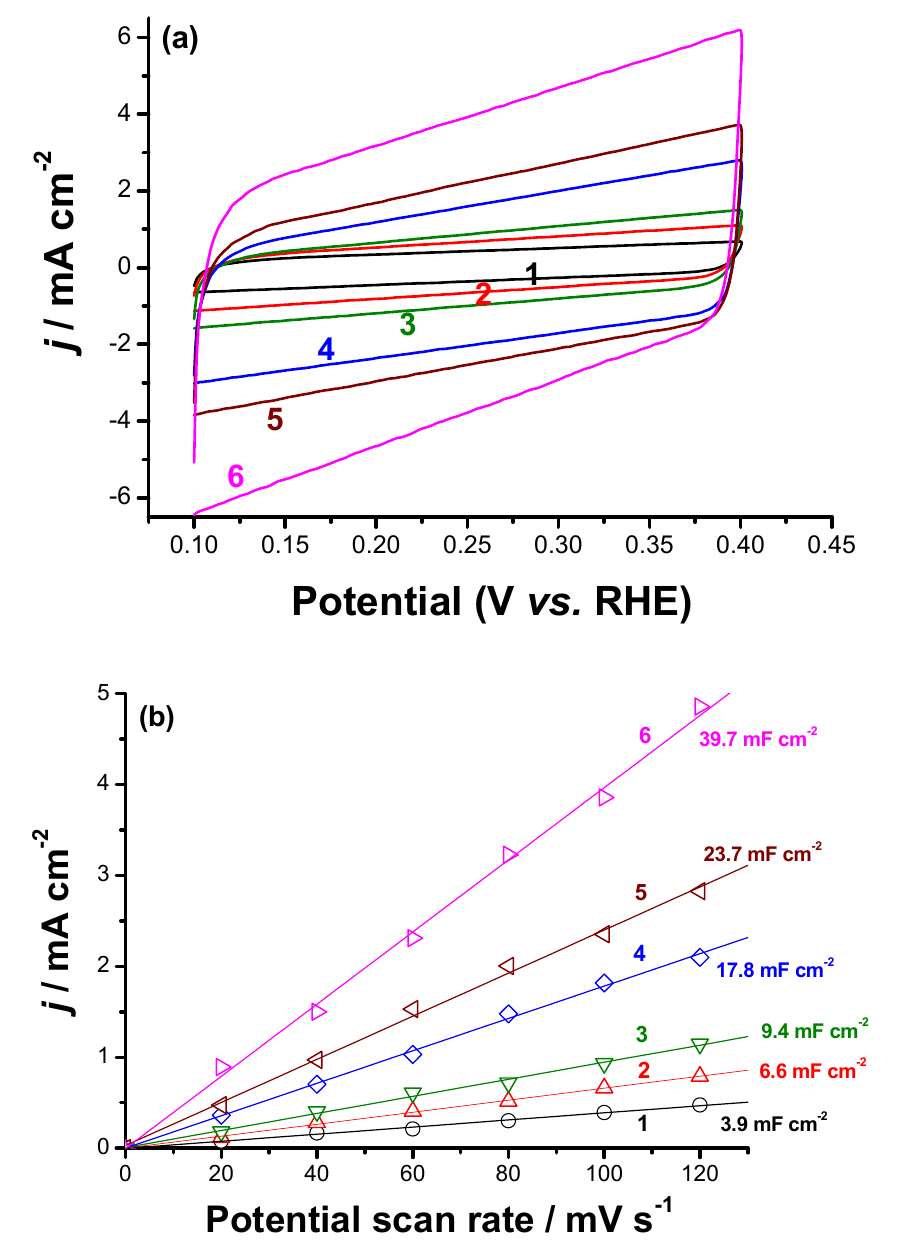
Figure 9. ( a ) CV measurements recorded for the investigated electrocatalysts. Measurements were conducted in 0.1 M KOH aqueous solution at a scan rate of 100 mV s − 1 at room temperature. ( b ) Double-layer capacitance measurements for determining the catalyst’s electrochemically-active surface area: (1) GC-FA (unactivated); (2) GC-FA (activated); (3) GC-TiO 2 (unactivated); (4) GC-TiO 2 (activated); (5) GC-(FA-TiO 2 ) (unactivated); (6) GC-(FA-TiO 2 ) (activated). The value of EASA is obtained by dividing the C dl value by C s , Equation (5), Table 3 [50].